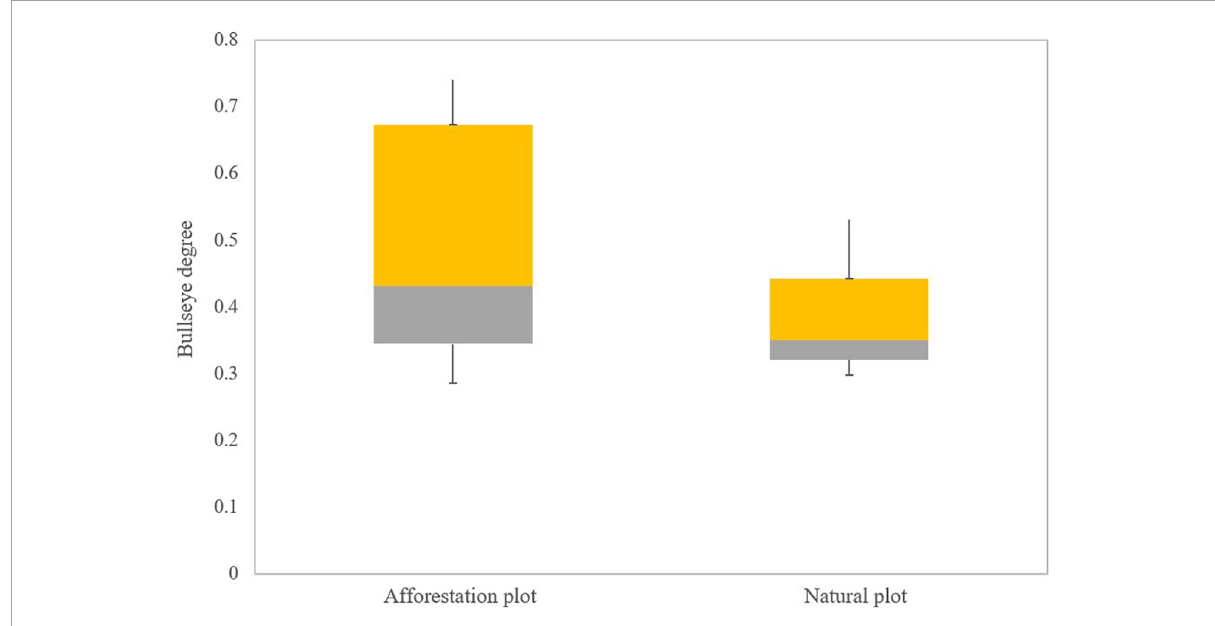
FIGURE8 Classification of soil quality grade.